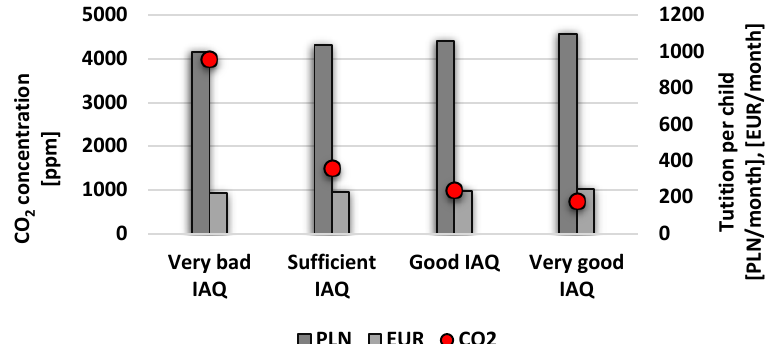
Figure 7. Annual costs of maintaining a given level of carbon dioxide concentration based on the number of children.